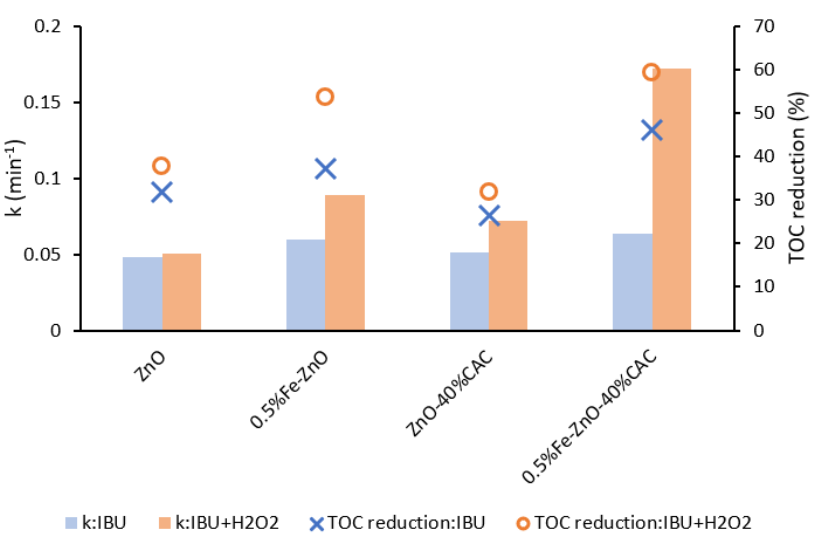
Figure 9. Comparison of degradation rate and mineralization of ibuprofen in the presence of different types of photocatalyst in the absence and presence of hydrogen peroxide. Experimental conditions: IBU initial conc.: 20 mg · dm − 3 , H 2 O 2 (5 mmol · dm − 3 ), V=15 cm 3 , photocatalyst: 0.5 g · dm − 3 , irradiation time=120 min.